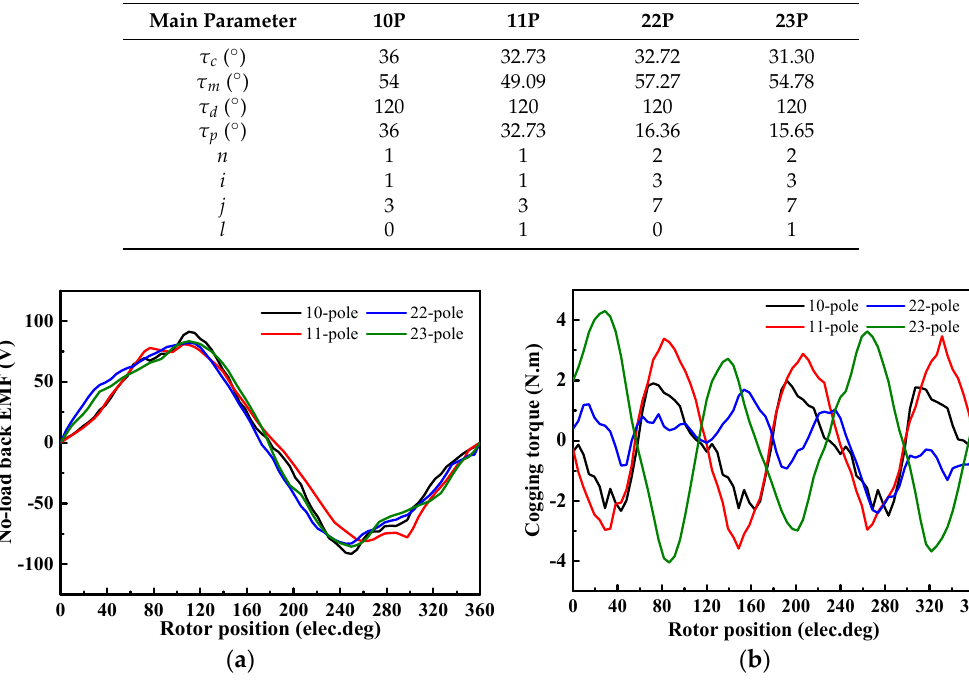
Figure 6. No-load performances of different MSOR-FSPM motors: ( a ) No-load back-EMF waveforms of winding A; ( b ) Cogging torque waveforms.